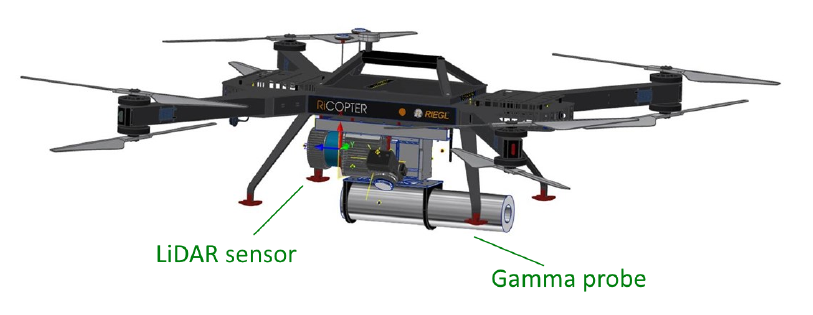
Figure 1. Carrier platform and sensor bundle comprising LiDAR sensor and gamma